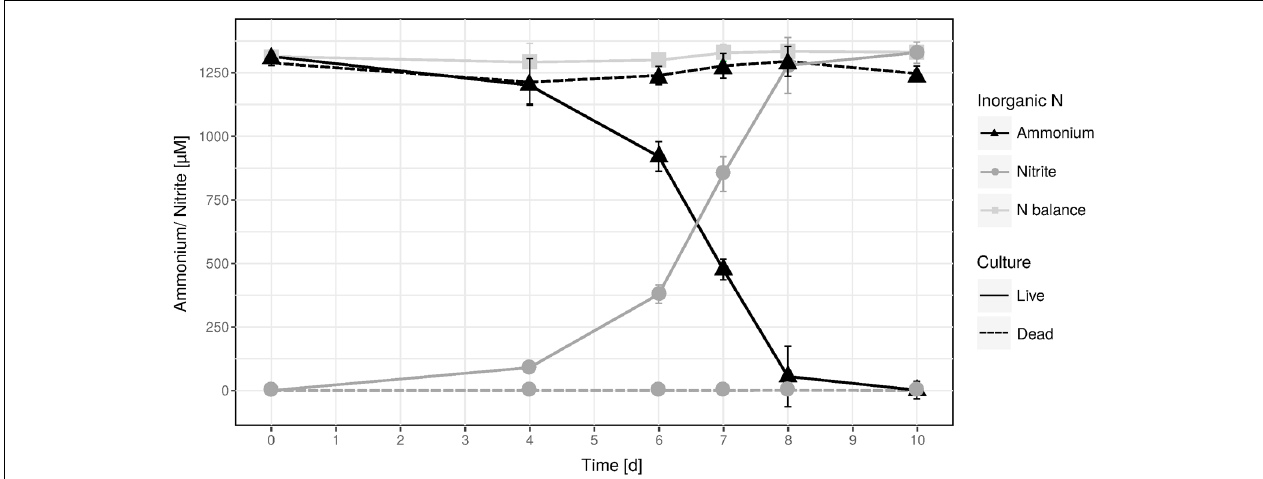
FIGURE 1 | Near-stoichiometric oxidation of 1.25 mM ammonium to nitrite by the “ Ca. N. islandicus” enrichment culture at 65 ◦ C. Data points show means, error bars show 1 SD of n = 3 biological replicates. Solid and dashed lines denote live and dead culture incubations, respectively. If not visible, error bars are smaller than